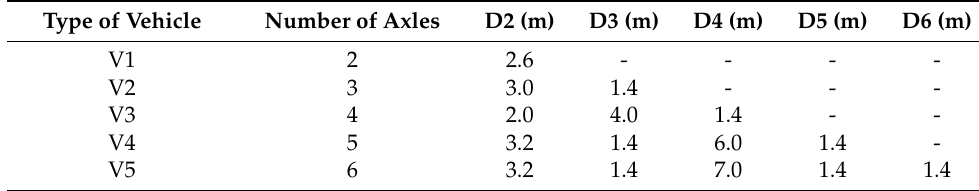
Table 1. Wheelbase information for different vehicles.